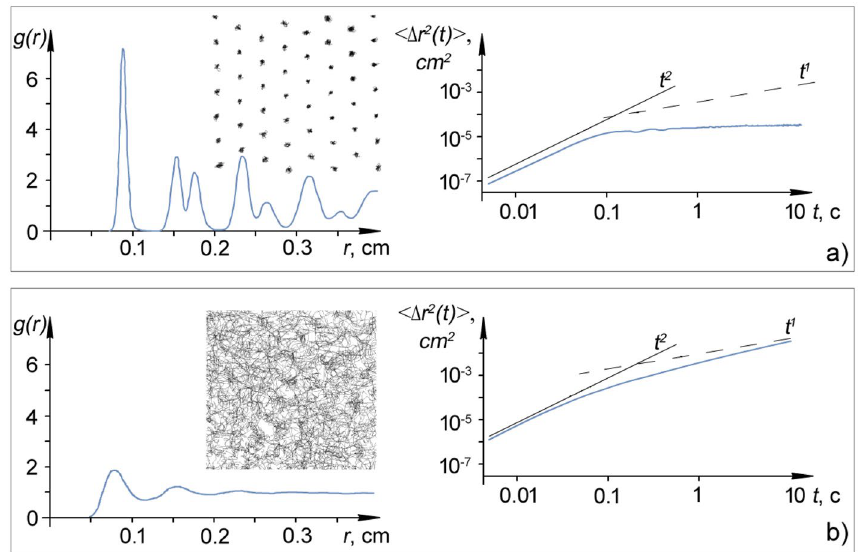
Figure 8. Pair correlation functions and root mean square displacements of grains and persistence length L at different states of the grain monolayer characterized by different values of laser power P las and kinetic energy E kin : ( a ) Γ * = 525, P las = 40 mW, E kin = 1.38 eV, L = 0.00107 cm; and ( b ) Γ * = 31, P las = 131 mW, E kin = 26.7 eV, L = 0.0148 cm. The insets to the graphs show the trajectories of grains in the structure during t = 5 s for different values of coupling parameter Г * , average kinetic energy E kin and persistence length